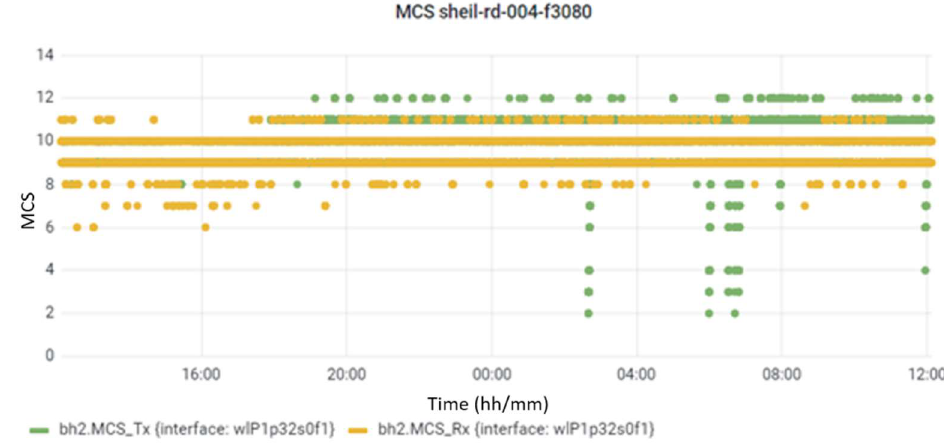
Figure 9. Performance in terms of MCS of Link 2.